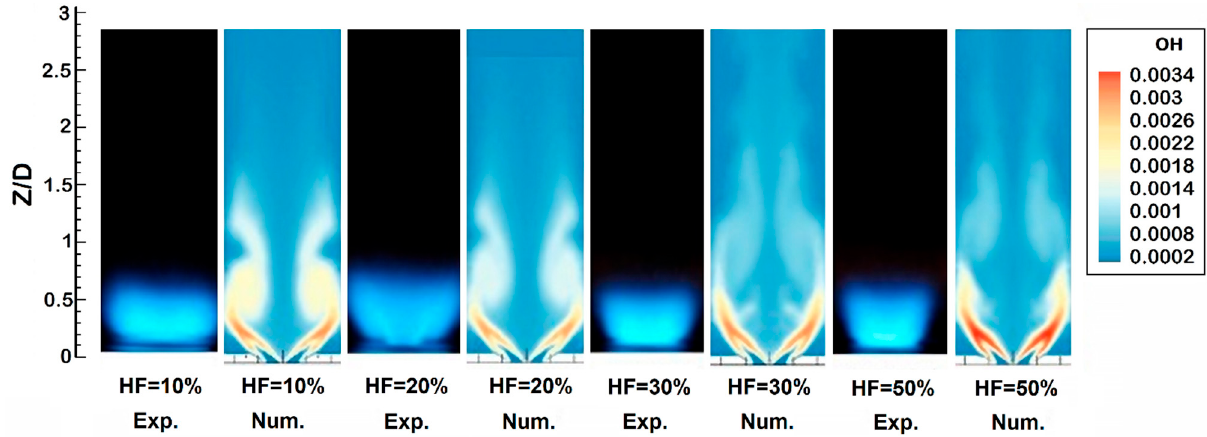
Figure 11. The flame shape in a swirled flow with various hydrogen additions by volume.